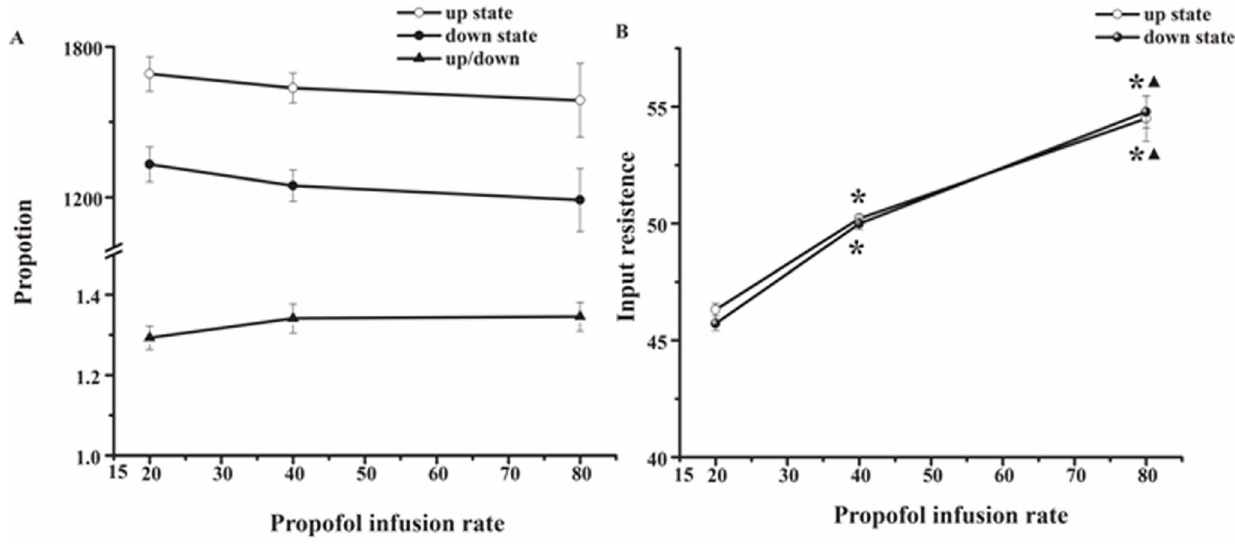
Figure 6. The up and down state in S1BF at different doses of propofol. A) The proportion of up state, down state and up/down state in S1BF and found no significant difference between the three groups. B) The relationship between the input resistance and different infusion rate. Compared with groups, the input resistance was larger than that in group A (20 mg/kg/h) and smaller than that in group C (80 mg/kg/h) *p , 0.05 and m p ,